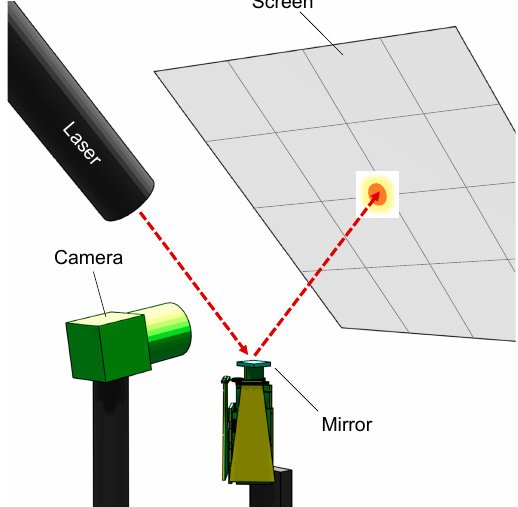
Figure A3. Evaluation setup. Figure A2. Evaluation